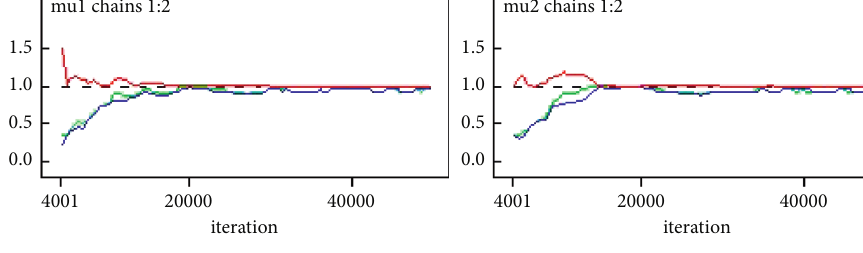
Figure 1: Gelman Rubin test results of μ